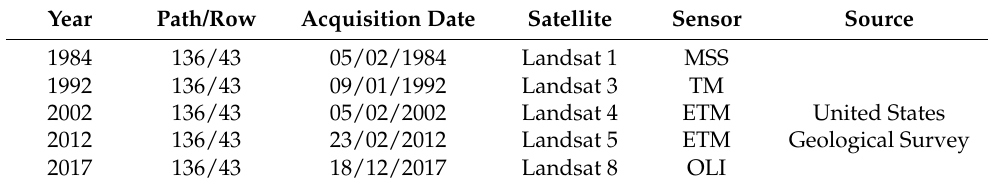
Table 1. List of Landsat satellite image information.